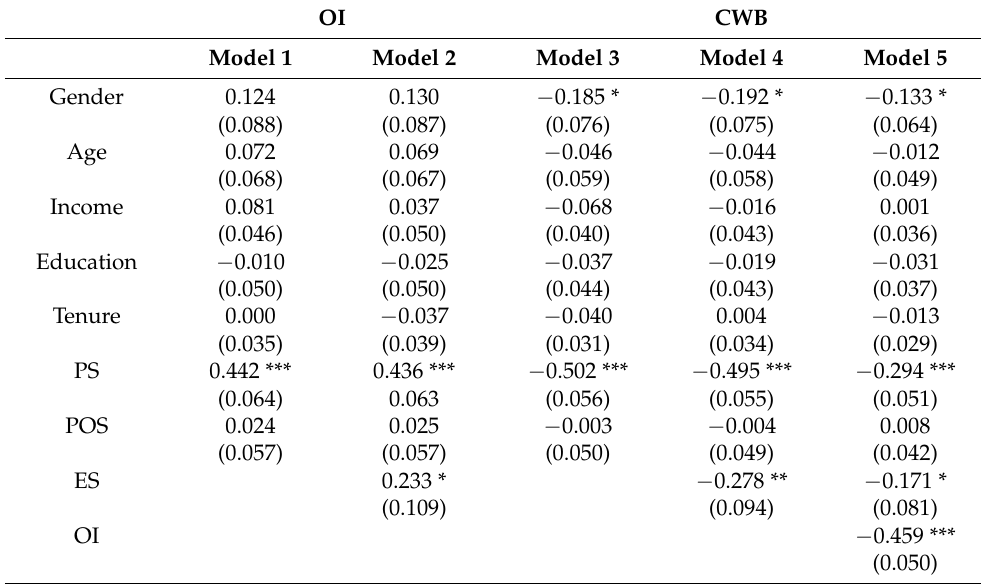
Table 4. Mediating effect of organizational